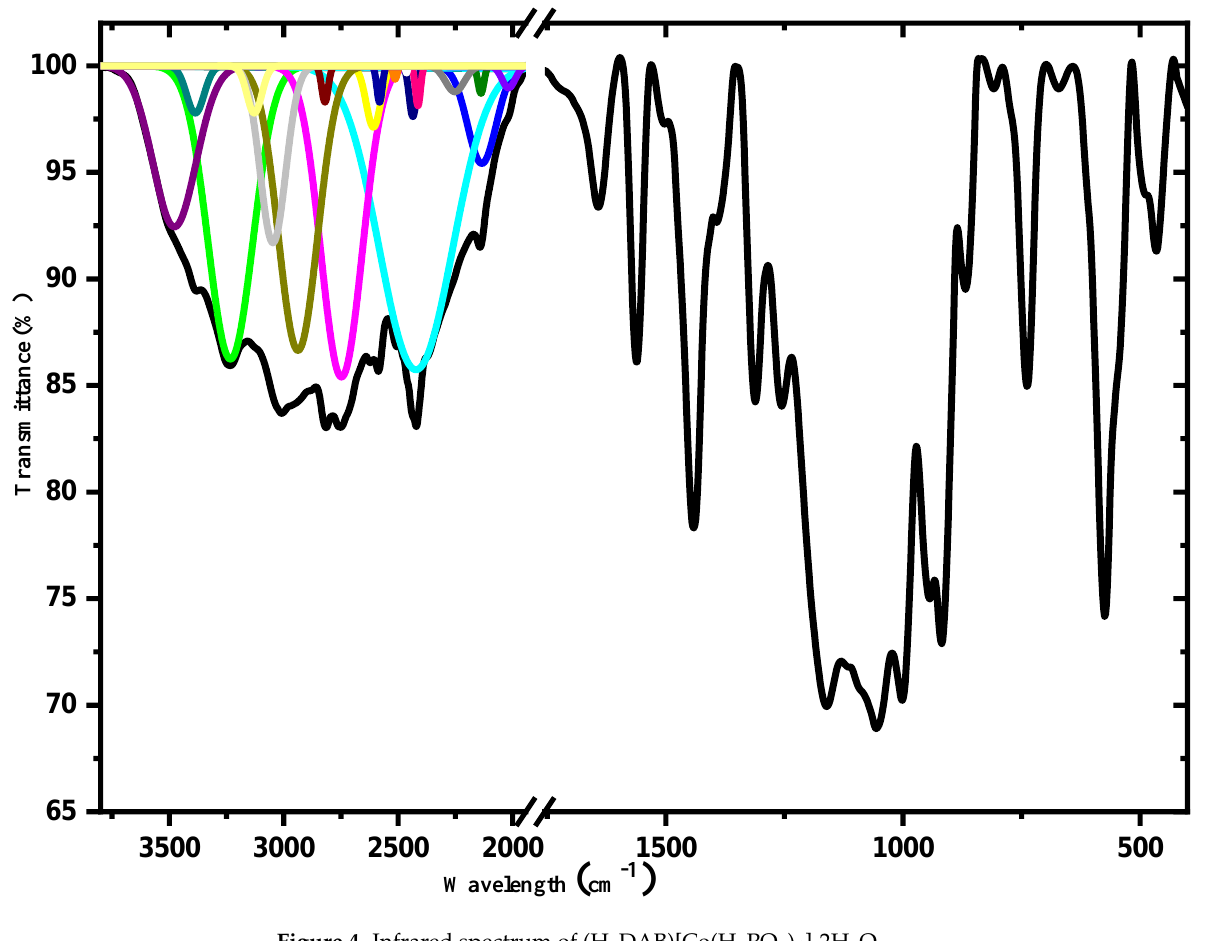
Figure 4. Infrared spectrum of (H 2 DAB)[Co(H 2 PO 3 ) 4 ]·2H 2 O.